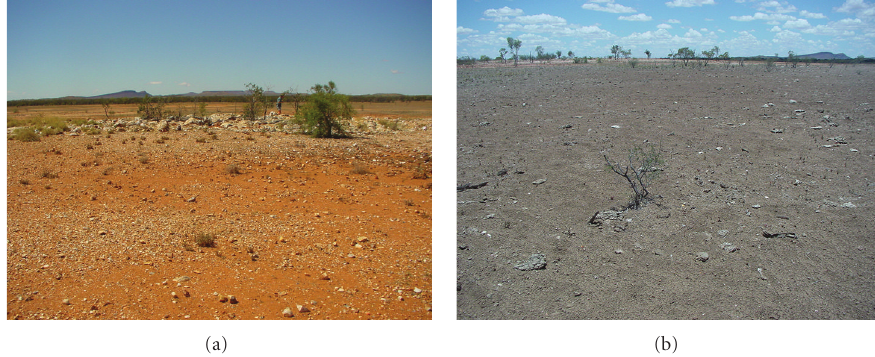
microFTIR 102 [32] (http://www.dpinstruments.com/).